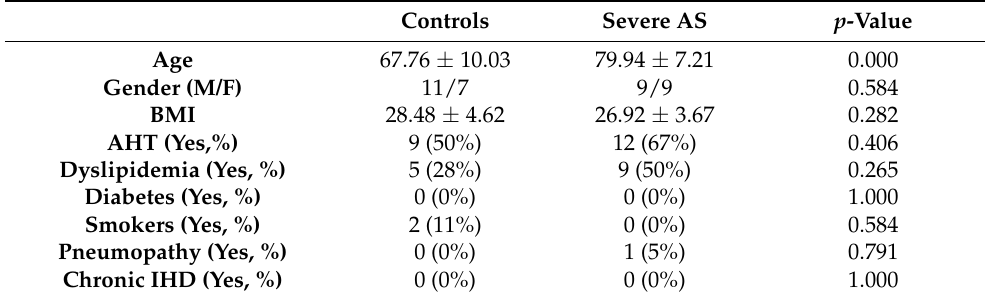
Table 3. Clinical characteristics of the subjects in the study: M/F, male/female; AHT, arterial hypertension; IHD, ischemic heart disease; BMI, body mass index.